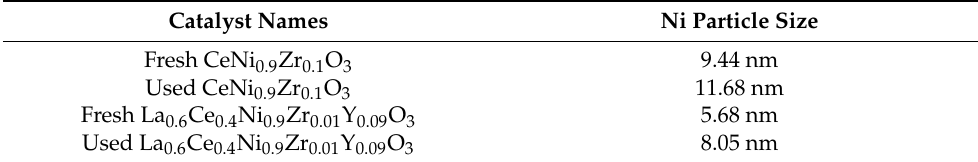
Figure 10. TEM of used La 0.6 Ce 0.4 Ni 0.9 Zr 0.01 Y 0.09 . Table 3. Nickel particle size derived from TEM